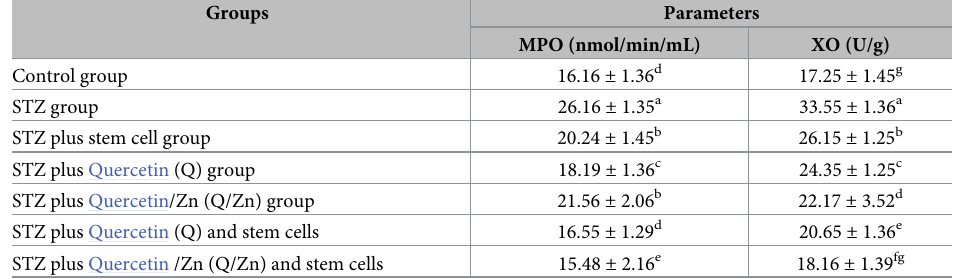
Table 6. Changes in MPO and XO in pancreatic tissues of control and treated male rats with quercetin, quercetin/Zn, or stem cells and their combinations.